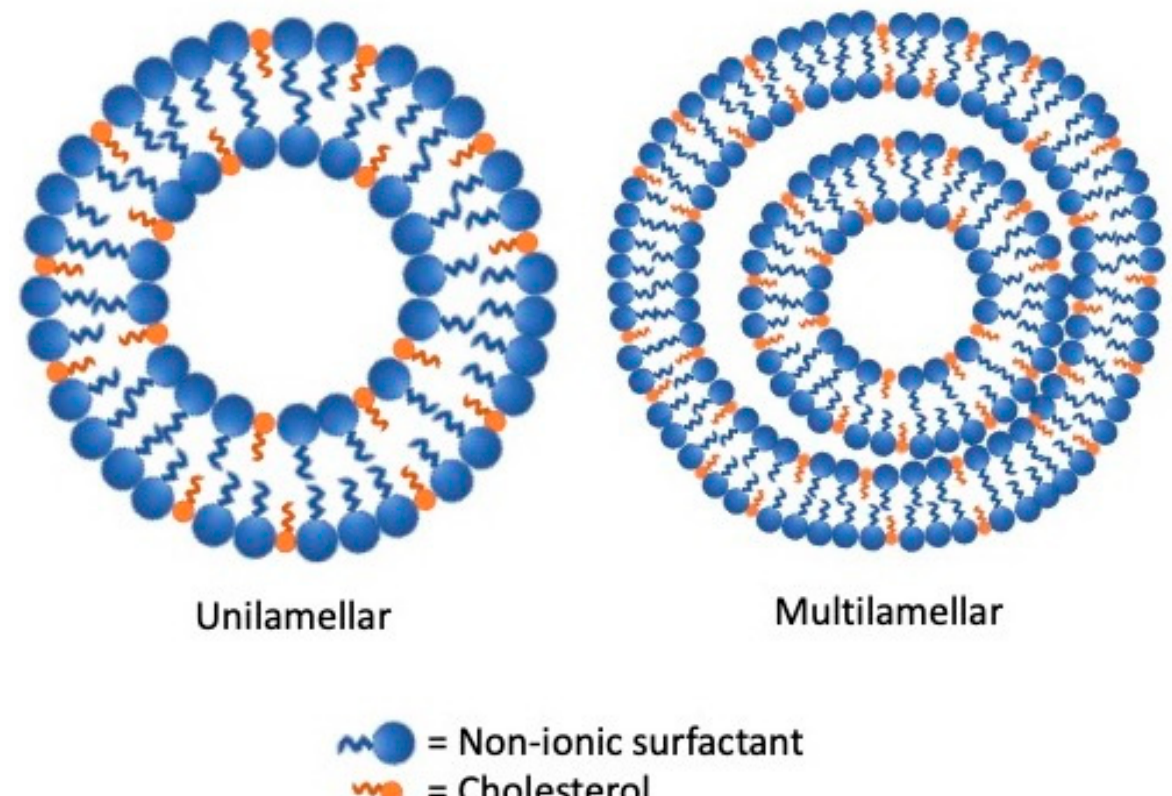
Figure 2. Structure of niosomes lipid vesicular systems.